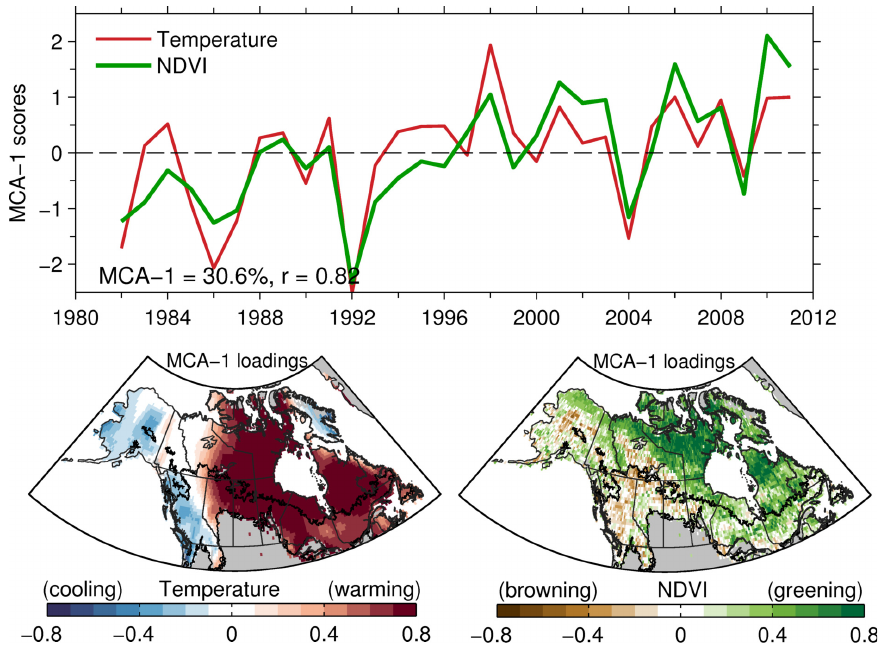
Figure 11. Temporal and spatial patterns of the leading MCA mode between summer temperature and summer NDVI fields in boreal and Arctic regions of North America computed over the period 1982–2011. This mode explains 31% of the total cross-covariance and the correlation between the corresponding time expansion coefficients is 0.82.